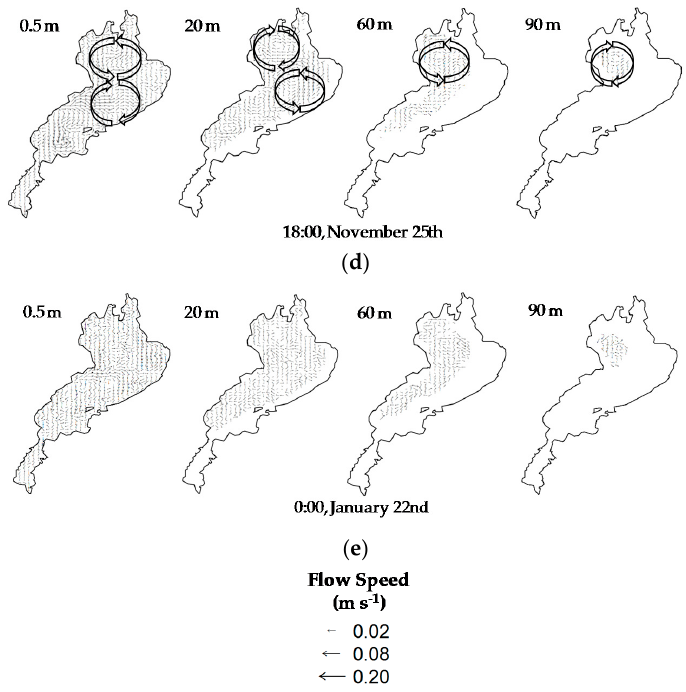
Figure 8. Flow field in each layer from May of 2007 to January of 2008 ( a ) 20 May; ( b ) 17 July; ( c ) 8 September; ( d ) 25 November; ( e ) 22 January.